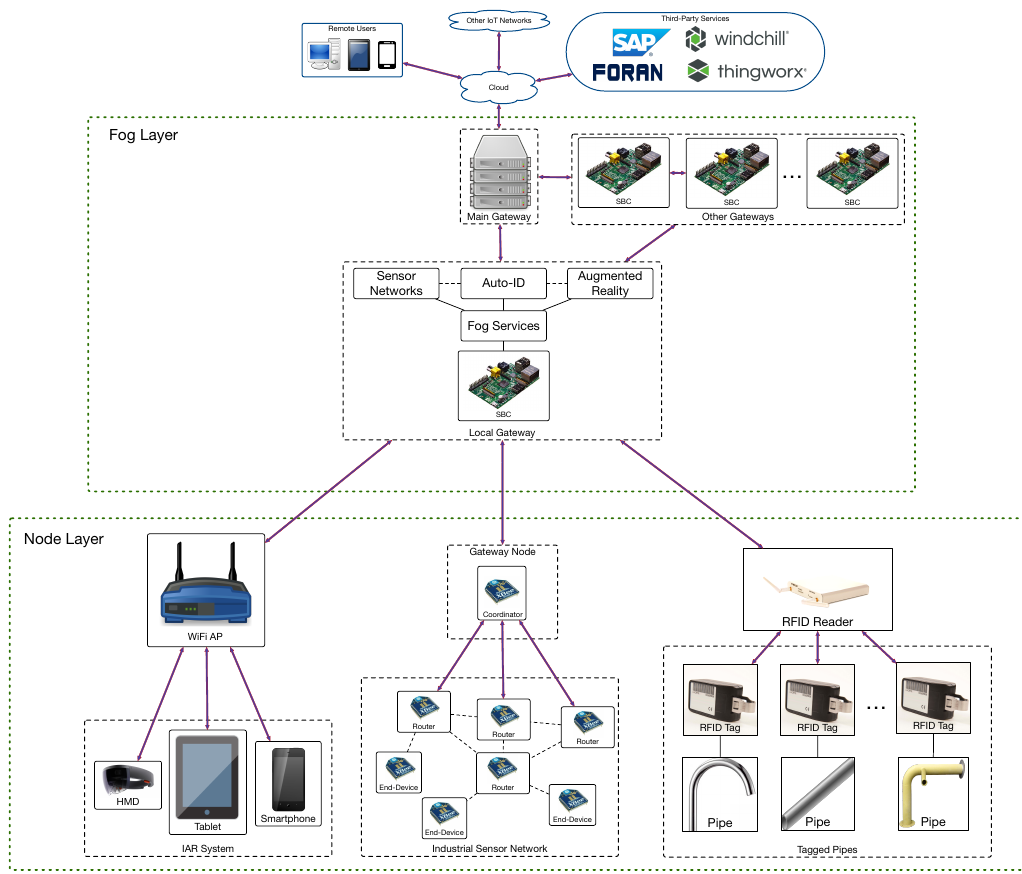
Figure 6. Fog-computing architecture of the proposed